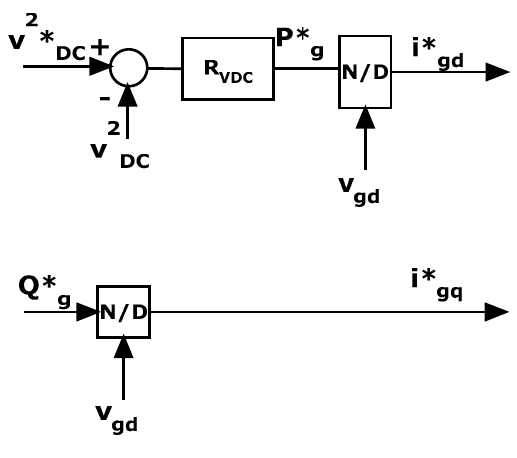
Figure 8. GSC controller architecture.